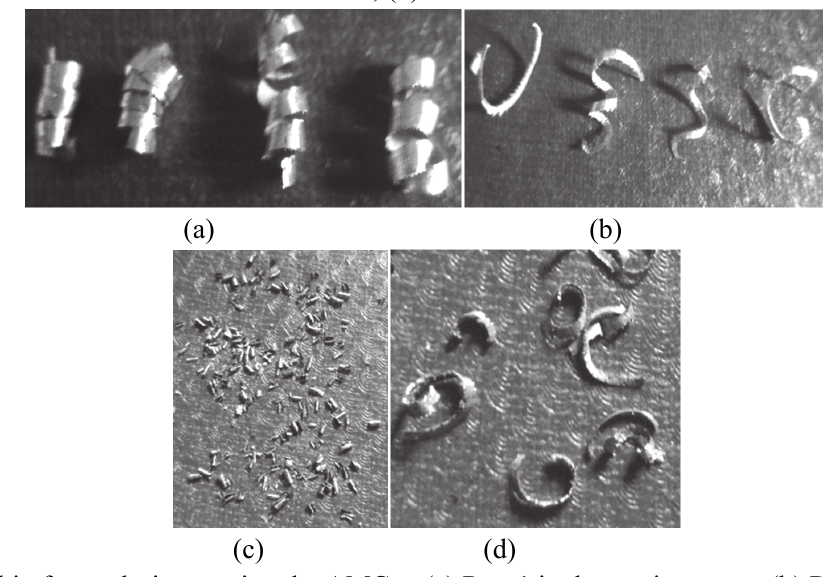
Fig. 11. Chip forms during turning the AMC at (a) Run 1 in dry environment; (b) Run 15 in dry environment; (c) Run 1 in SIC environment; and (d) Run 15 in SIC